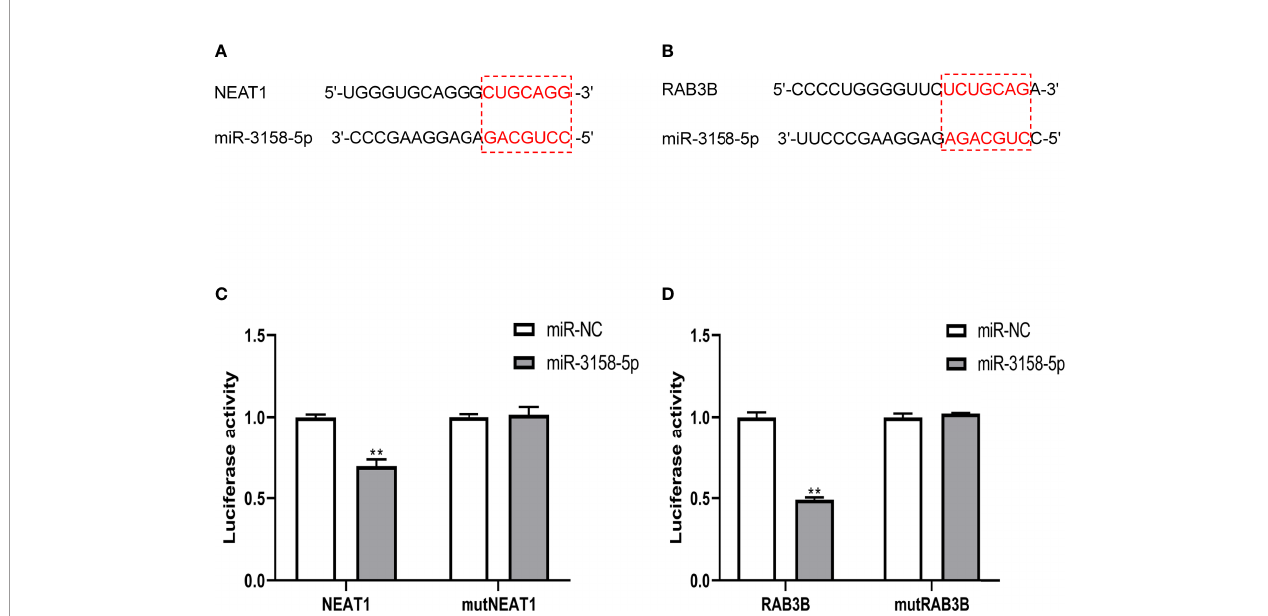
FIGURE 7 | NEAT1 and RAB3B were direct targets of miR-3158-5p. (A) The binding site sequence between NEAT1 and miR-3158-5p. (B) The binding site sequence between RAB3B and miR-3158-5p. (C) Luciferase reporter assay veri fi ed the direct binding effect between NEAT1 and miR-3158-5p. (D) Luciferase